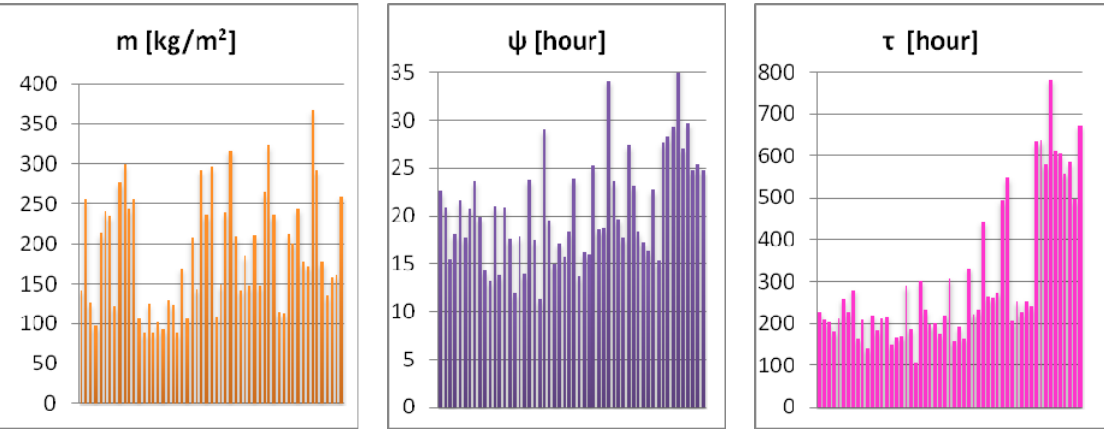
Figure 12. Mass per unit area, phase shift of thermal oscillation, and relaxation time of roof